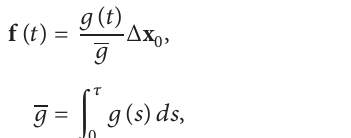
Figure 1: The schematic diagram of the IAU (blue), the NIAU (red), and the intermittent method (gray). It is assumed that the total time step ( 𝑁 ) is 3, and the system is